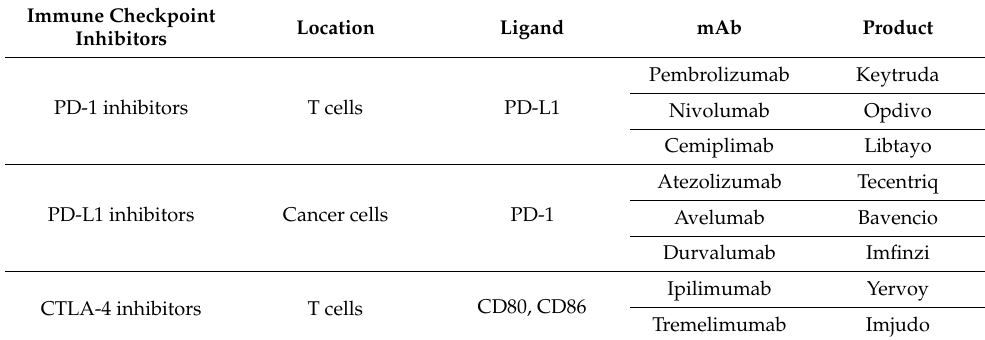
Table 4. Clinically approved ICI